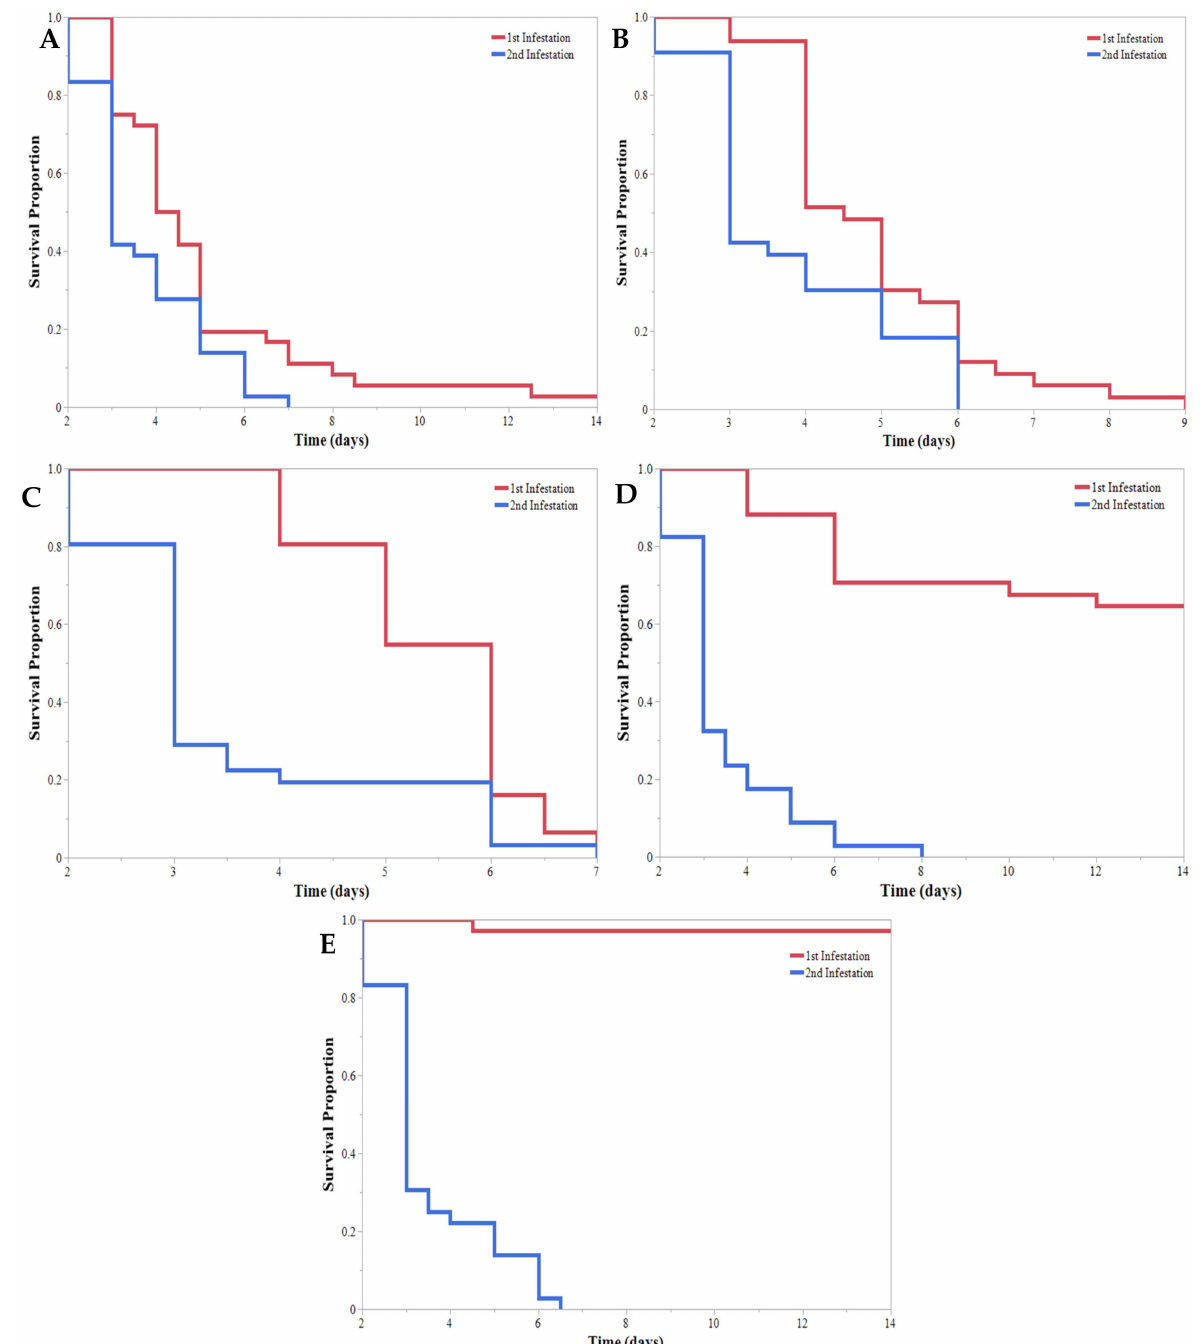
Figure 7. Kaplan–Meier survival curves comparing the different times to mortality for the 1st infestation and the 2nd infestation of Helicoverpa zea (Lepidoptera: Noctuidae) on V3 soybeans sprayed with Helicoverpa armigera nucleopolyhedrovirus. ( A ) The 1st instar larvae from the 1st infestation survived significantly longer than 2nd instar larvae from the 2nd infestation. Log-rank test: χ 2 = 6.916, p = 0.0085. ( B ) The 2nd instar larvae from the 1st infestation survived significantly longer than 2nd instar larvae from the 2nd infestation. Log-rank test: χ 2 = 8.081, p = 0.0045. ( C ) The 3rd instar larvae from the 1st infestation survived significantly longer than 2nd instar larvae from the 2nd infestation. Log-rank test: χ 2 = 17.869, p < 0.0001. ( D ) The 4th instar larvae from the 1st infestation survived significantly longer than 2nd instar larvae from the 2nd infestation. Log-rank test: χ 2 = 60.032, p < 0.0001. ( E ) The 5th instar larvae from the 1st infestation survived significantly longer than 2nd instar larvae from the 2nd infestation. Log-rank test: χ 2 = 79.544, p <